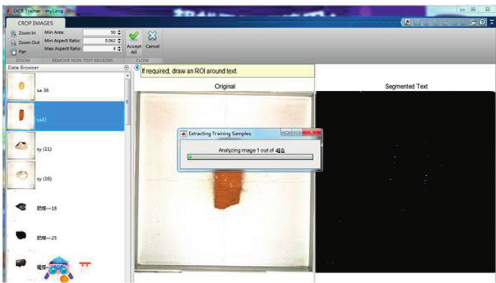
Figure 8: Training sample